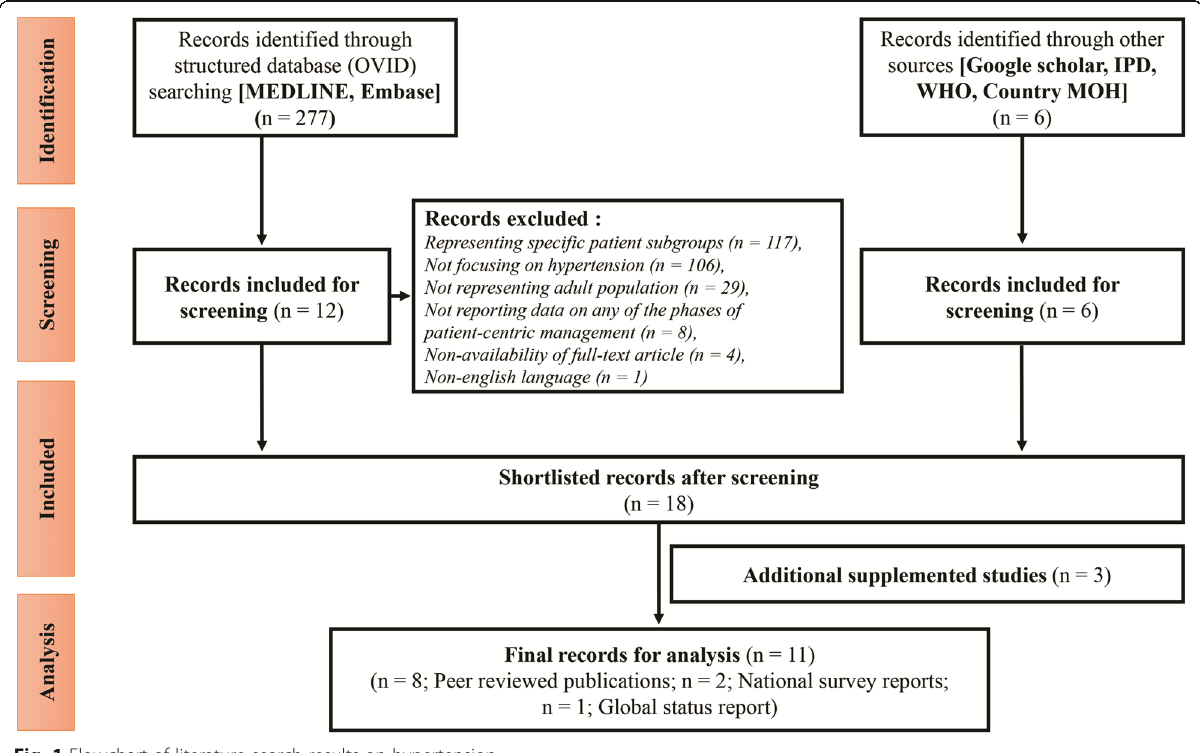
Fig. 1 Flowchart of literature search results on